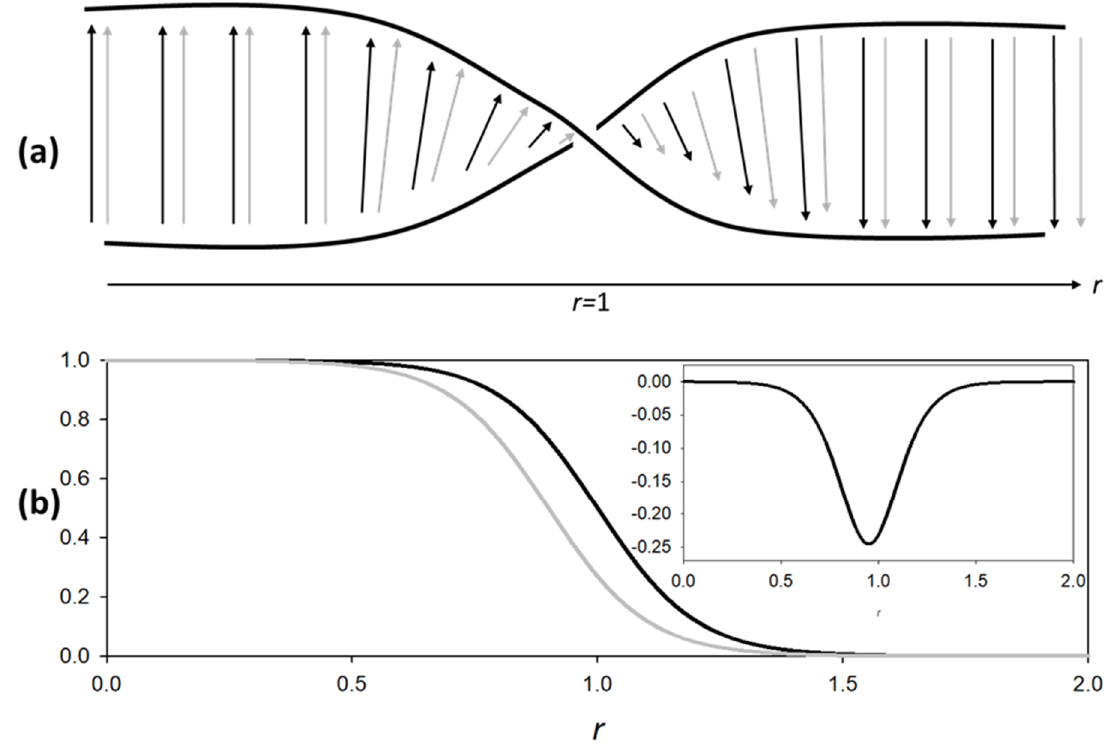
Figure 9. ( a ) Schematic illustration of the twisted ribbon manifold supporting the state vector of the un-defected (black arrows) and defected (grey arrows) arrays of waveguides a (cid:1870) is varied. The grey un-defected (black arrows) and defected (grey arrows) arrays of waveguides a r is varied. The grey arrows are translated to the right along the (cid:1870) axis leading to an additional rotation for a given (cid:1870) arrows are translated to the right along the r axis leading to an additional rotation for a given r due due to scattering. ( b ) Rotation angle of the state vectors, (cid:2016) (cid:3049)(cid:3050) , (in units of (cid:2024) ) for the undefected (black to scattering. ( b ) Rotation angle of the state vectors, θ vw , (in units of π ) for the undefected (black line) and defected (grey line) systems. Inset, ∆(cid:2016) = (cid:2016) (cid:3049)(cid:3050) (defected) − (cid:2016) (cid:3049)(cid:3050) (undefected) as a function of line) and defected (grey line) systems. Inset, ∆ θ = θ vw ( defected ) − θ vw ( undefected ) as a function of driving parameter r. driving parameter r